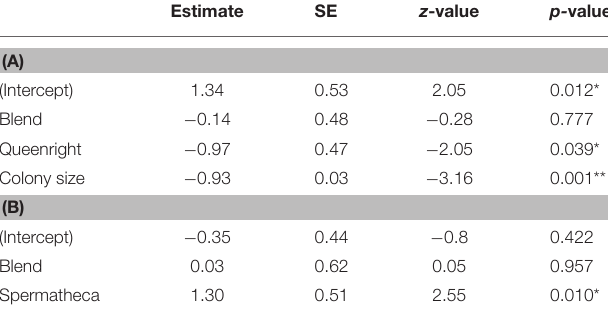
TABLE 1 | (A) Binomial generalized linear mixed model output testing for differences in the proportion of Polistes satan females with activated ovaries across our different treatments. In this model, colony, treatment, and colony size were included as a random intercept, a fixed factor, and a continuous covariate. Significance levels are based on Wald z tests for the difference between the treatment and the queenless control (intercept, shown between brackets). (B) Binomial generalized linear mixed model output testing for differences in the proportion of mated Polistes satan females with developed ovaries where the dominant breeder had been removed. * p < 0.05; ** p <